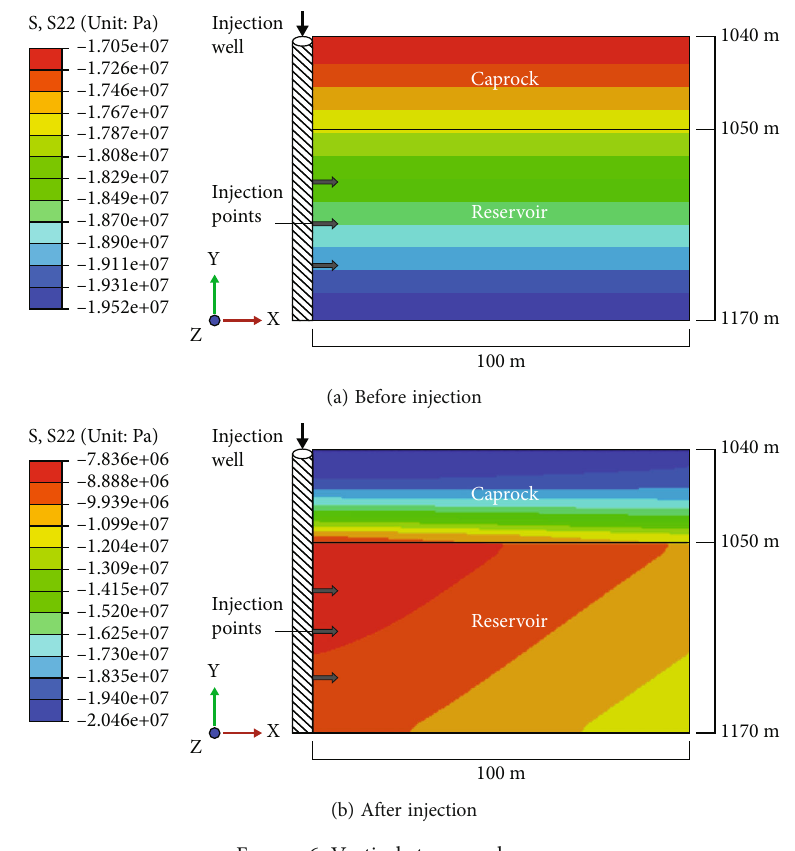
Figure 6: Vertical stress nephogram.